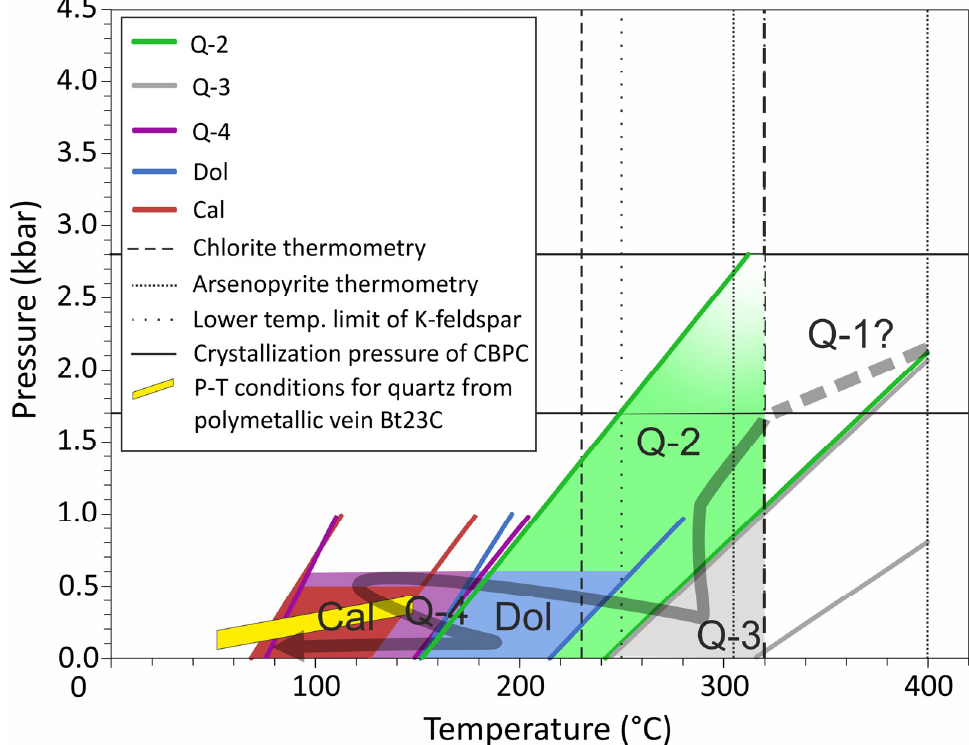
Figure 28. Estimated P–T conditions for the studied Au-bearing vein based on a combination of isochors of fluid inclusions and independent temperature/pressure estimates. Thick grey curve illustrates possible evolution trend. The P–T field for late quartz from base-metal vein Bt23C is based on fluid inclusions containing immiscible aqueous-carbonic fluids (Ulmanová et al. [5]).